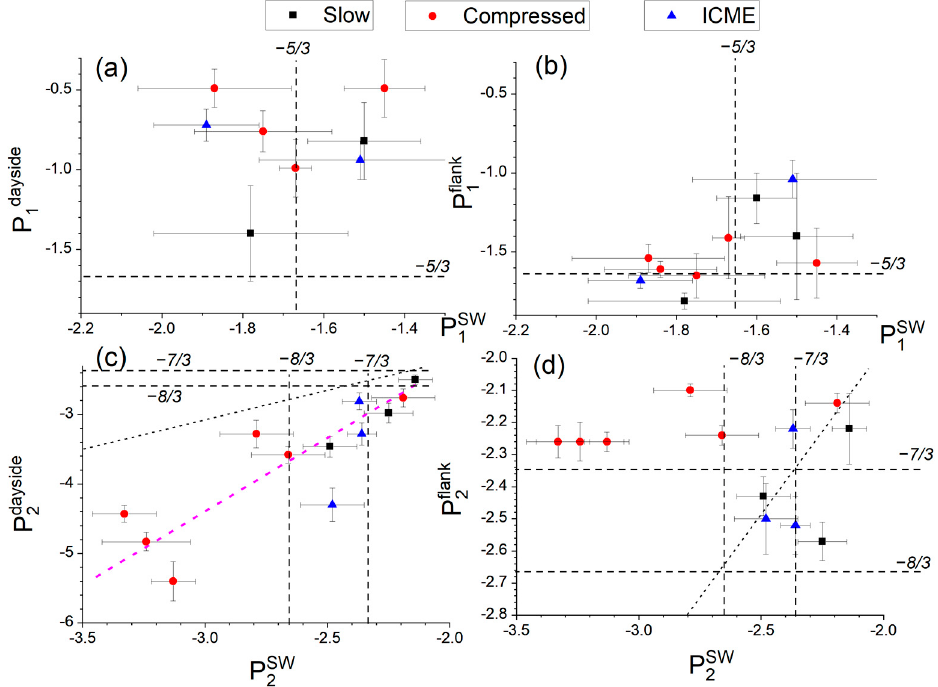
Figure 6. Spectral slopes at the MHD scales ( a , b ) and at the kinetic scales ( c , d ) at the dayside MSH vs. the SW ( a , c ) and at the flank MSH vs. the SW ( b , d ); colors denote different large-scale SW type: Slow (black), ICME (blue), Compressed (red).